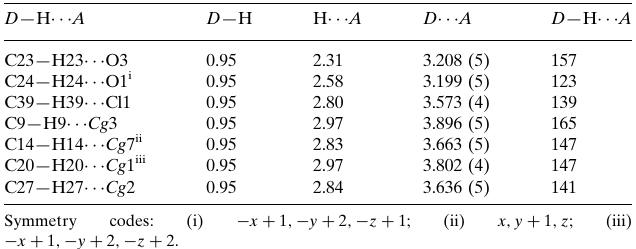
Data collection Bruker SMART APEX CCD area- detector diffractometer Absorption correction: multi-scan ( SADABS ; Bruker, 2007) T min = 0.913, T max = 0.944